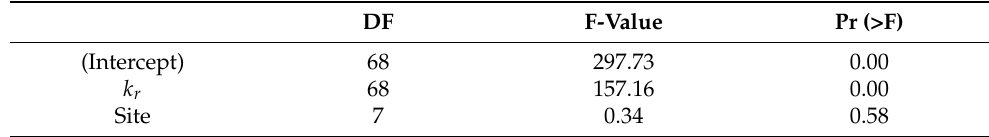
= β + β × k r + β × Site 0 2 1 ij ij